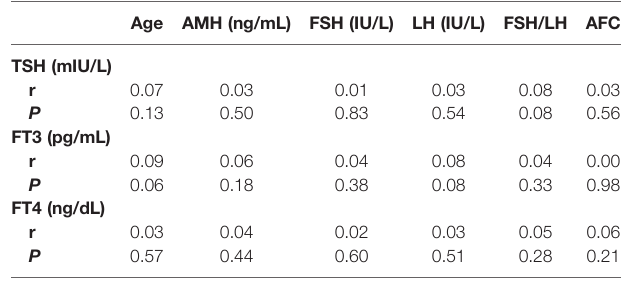
TABLE 2 | Correlation analysis of thyroid hormone and ovarian reserve function.